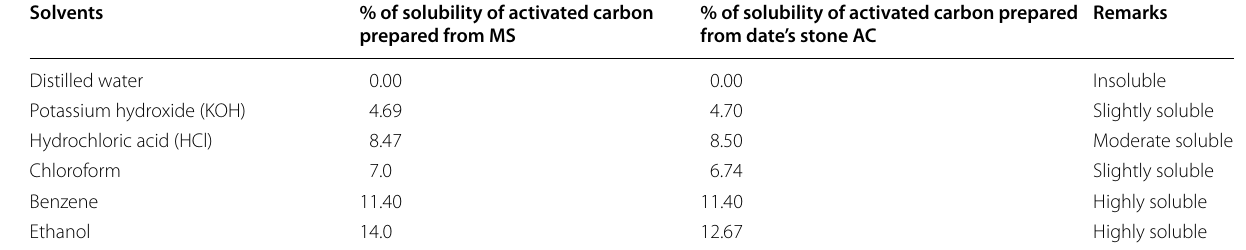
Table 1 The solubility test (O.1% of activated carbon) in different solvents